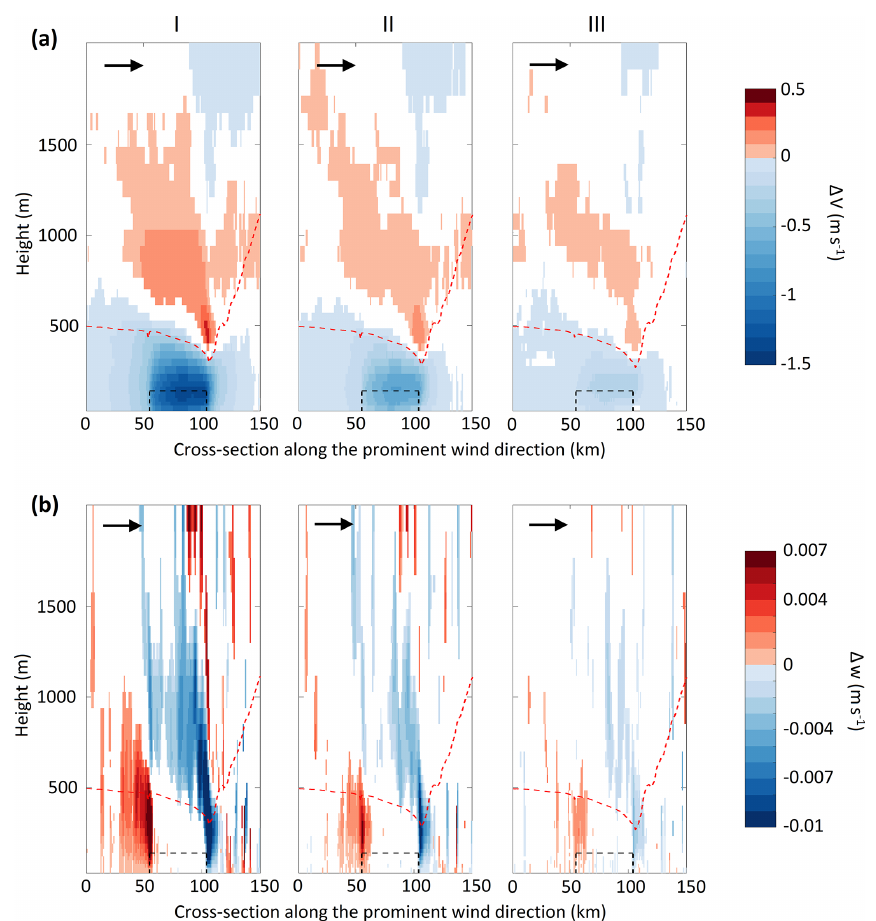
Figure 6. Difference (WF-CTRL) in (a) horizontal wind velocities, (cid:49)V (ms − 1 ) and, (b) vertical wind velocity, (cid:49)w (ms − 1 ) on a vertical cross-section along the predominant wind direction for (I) case: I, (II) case II, and (III) case III. Only the statistically significant differences ( p < 0 . 01) are shown here. The white-colored regions represent areas where the differences are not significant. The black dashed box depicts the wind farm cross-section. The red dashed line depicts ABL height in the corresponding WF case. The black arrow represents the prominent wind direction. Difference in wind velocities is averaged over 5 sea-breeze days for 12:30 to